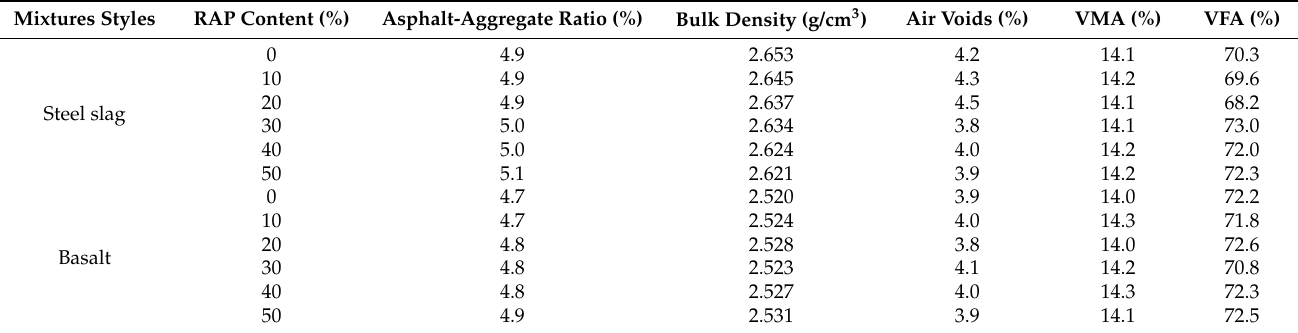
Table 2. Volume performance parameters of